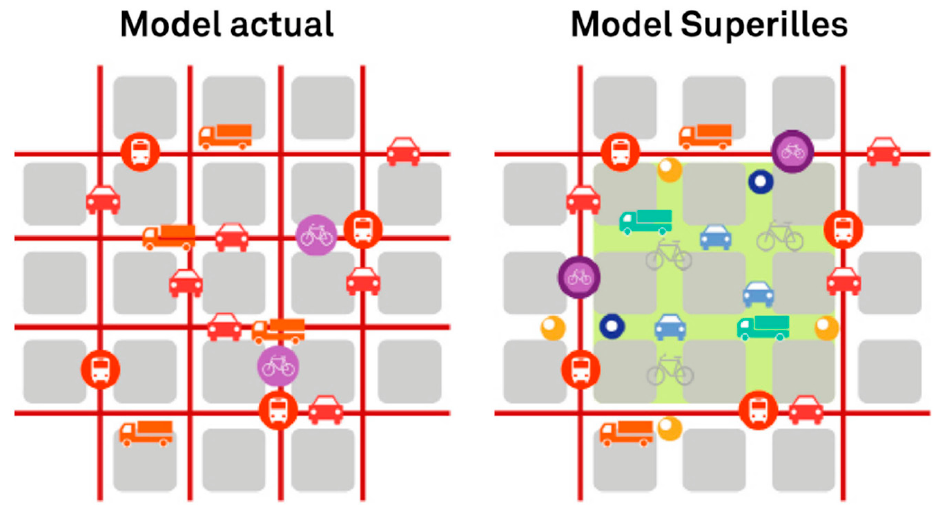
Figure 5. The homogeneous street network of Cerda’s extension (current 2013 model, model actual ) vs. the superblock model proposed in Barcelona Urban Mobility Plan 2013–2018 (superblock model, model Superilles ). Source: Ajuntament de Barcelona [49].